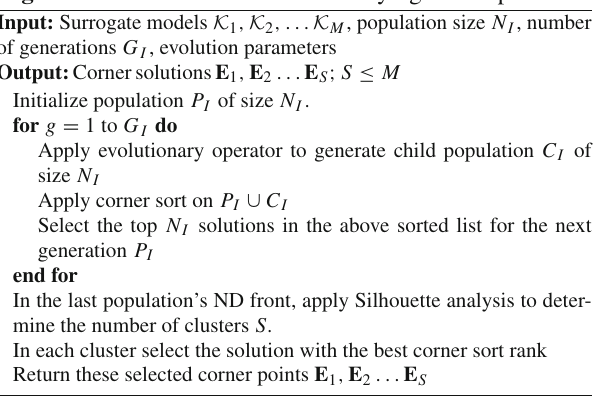
Algorithm 2 Corner search for identifying corner